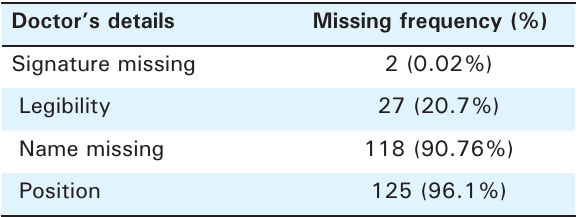
Table 6. Doctor’s details and missing